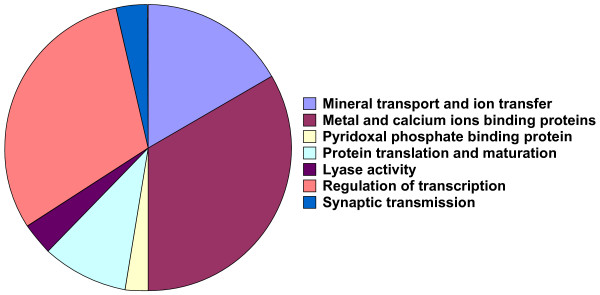
Piechart showing distribution of over-expressed uterine transcripts according to potential biological properties. EASE was used to determine GO terms (biological process and molecular function), enriched in the uterine transcriptome and classified in eight distinct groups according to their potential biological functions (see Table 1).